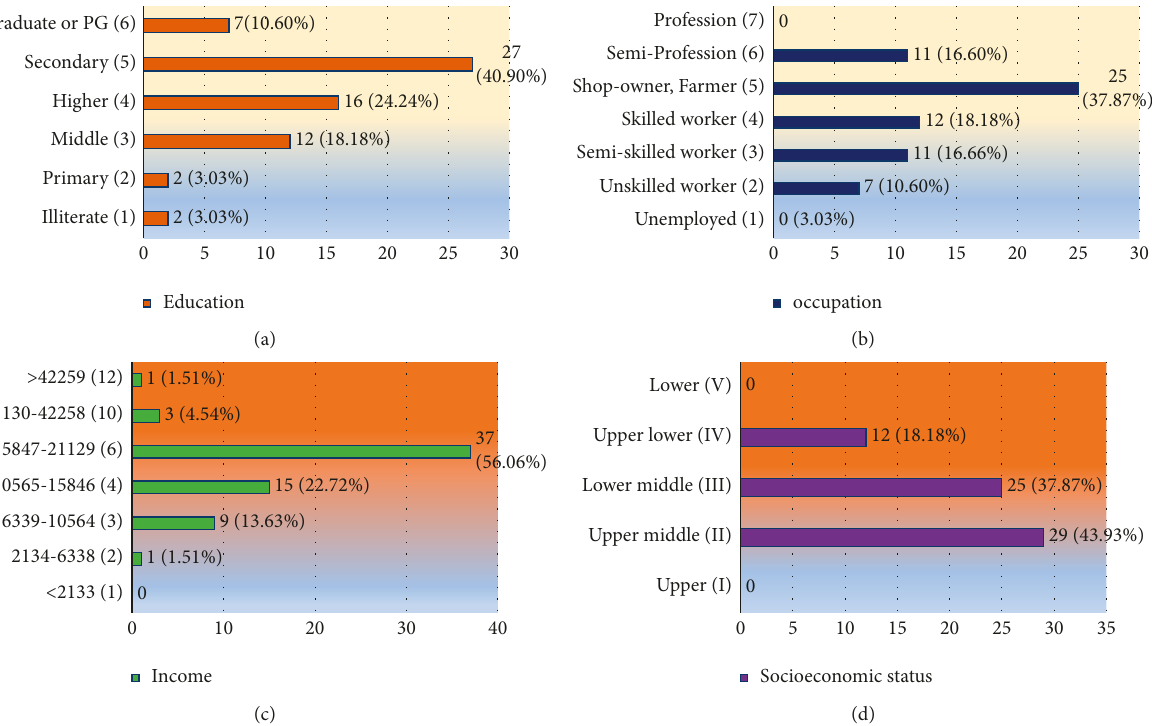
Figure 3: Socioeconomic status of patients with abnormal vaginal discharge. (a) Education. (b) Occupation. (c) Income. (d) Socioeconomic status.